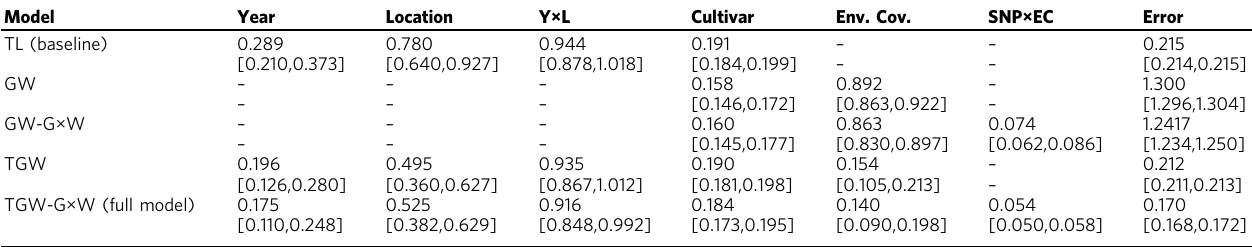
Table 1 Estimated variance components [95% credible interval] for wheat grain yield.